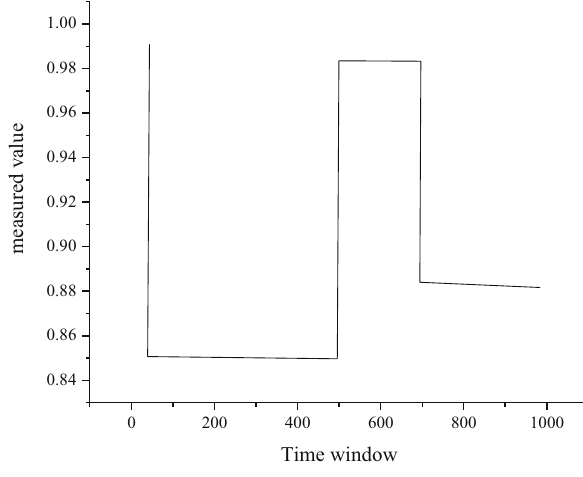
Figure 5: Change diagram of the original data